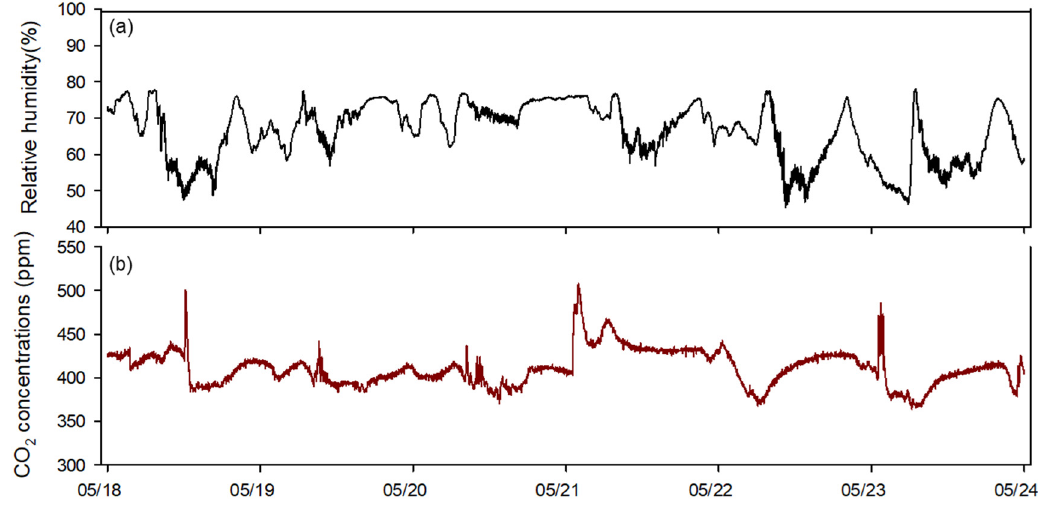
Figure 13. Changes in inside environmental conditions in the experiment greenhouse: relative humidity ( a ), CO 2 concentration ( b ).